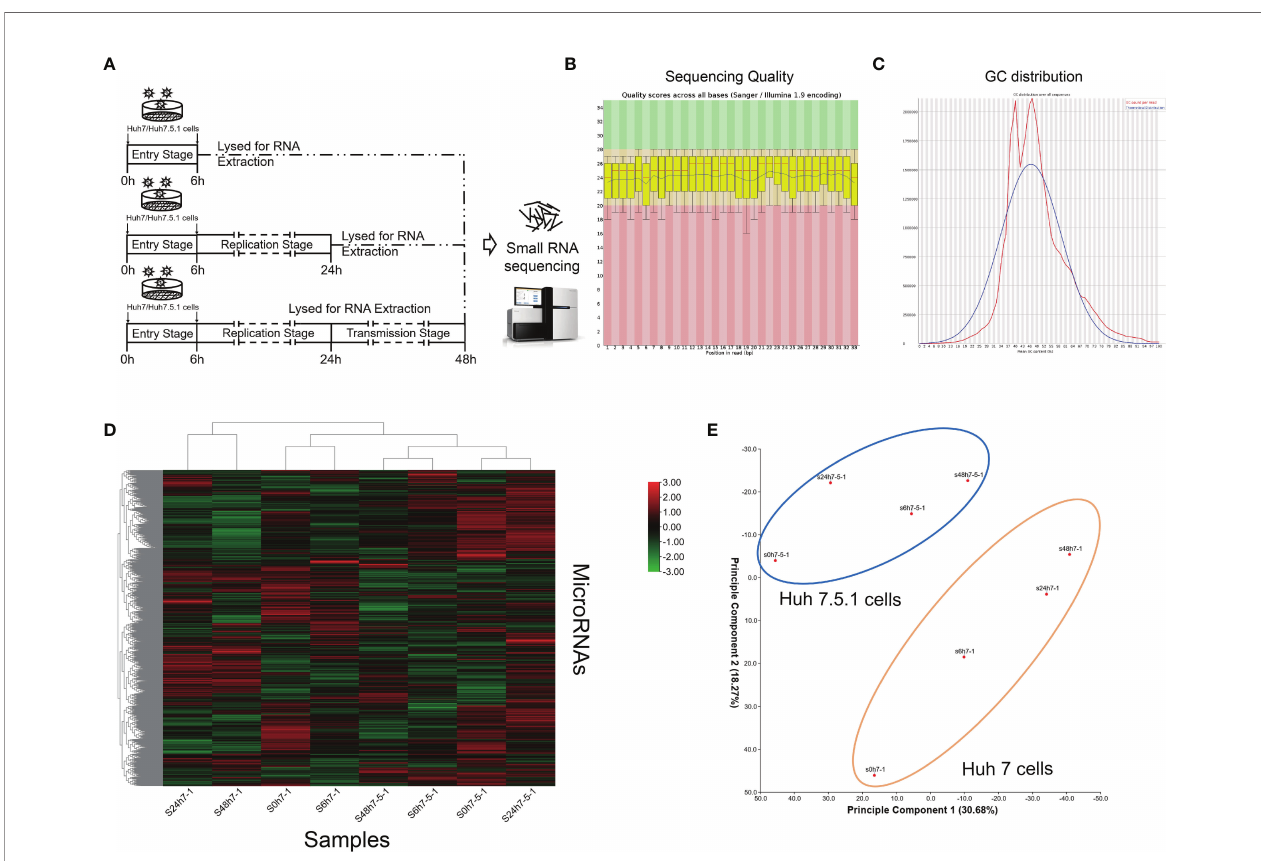
FIGURE 1 | miRNA expression pro fi les of high-throughput sequencing analysis during HCV infection. (A) Schematic graph of small RNA sequencing. (B) Representative images of sequencing quality scores of the samples. (C) GC distribution of the sequencing data. (D) Hierarchical clustering of the sequenced samples. Note that samples of the same cell line were clustered together, and the time point was chosen according to miRNA deviation degree during HCV infection. The red color represented upregulated miRNAs, and green color represented downregulated miRNAs. (E) Principal component analysis showing the distribution of samples. Note that the samples of same cell line were circled